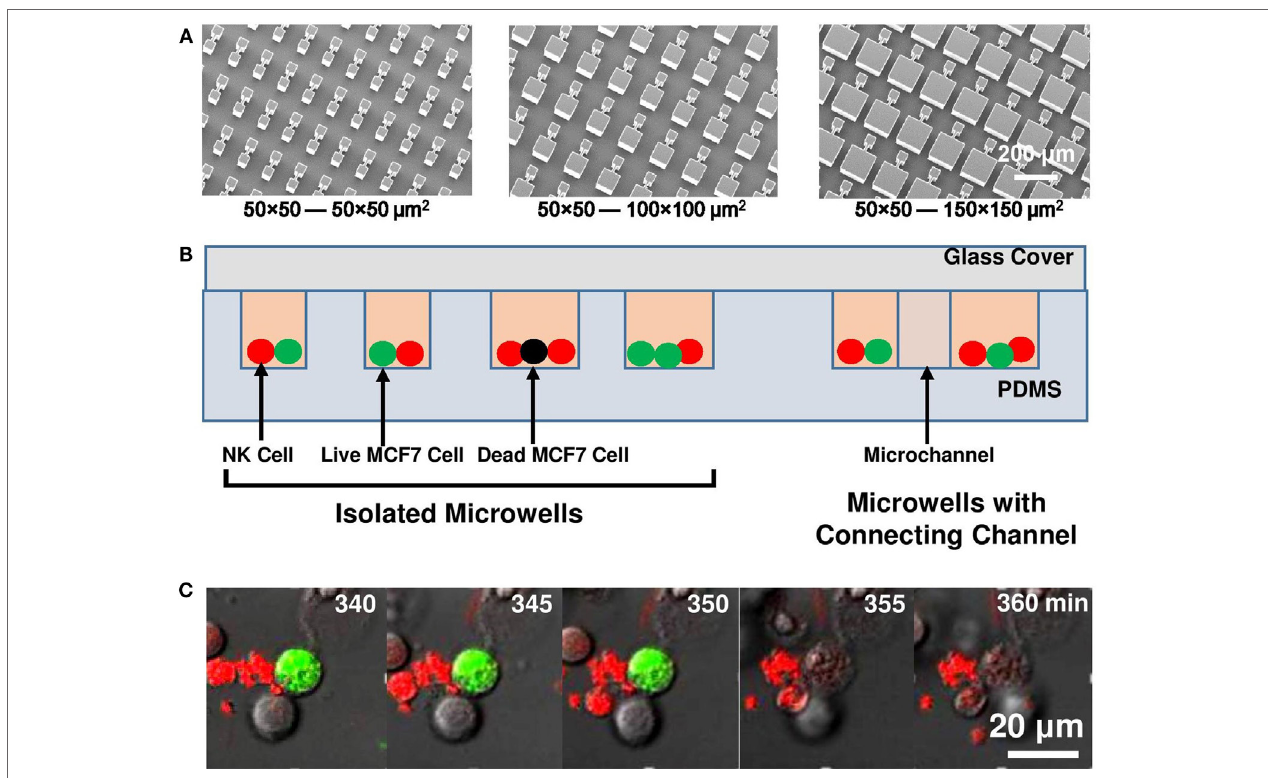
FigUre 1 | Experiment setup. (a) Micrographs of SU-8 stamps to duplicate polydimethylsiloxane (PDMS) platforms. (B) Schematic of microwell and microchannel arrays with natural killer (NK) cells (red) and MCF7 cells (green: live; black: dead) loaded. (c) Sequence of MCF7 cell lysis as MCF7 cell lost its green fluorescent protein signal at 355